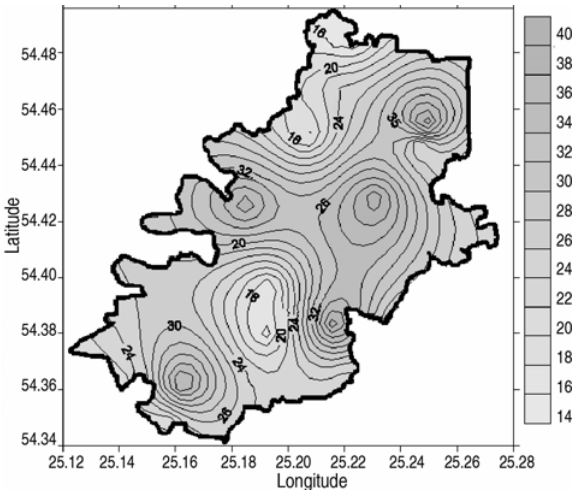
Fig 4 . Distribution of radon exhalation rate from the soil in the territory of Vilnius city, Bq m –2 h